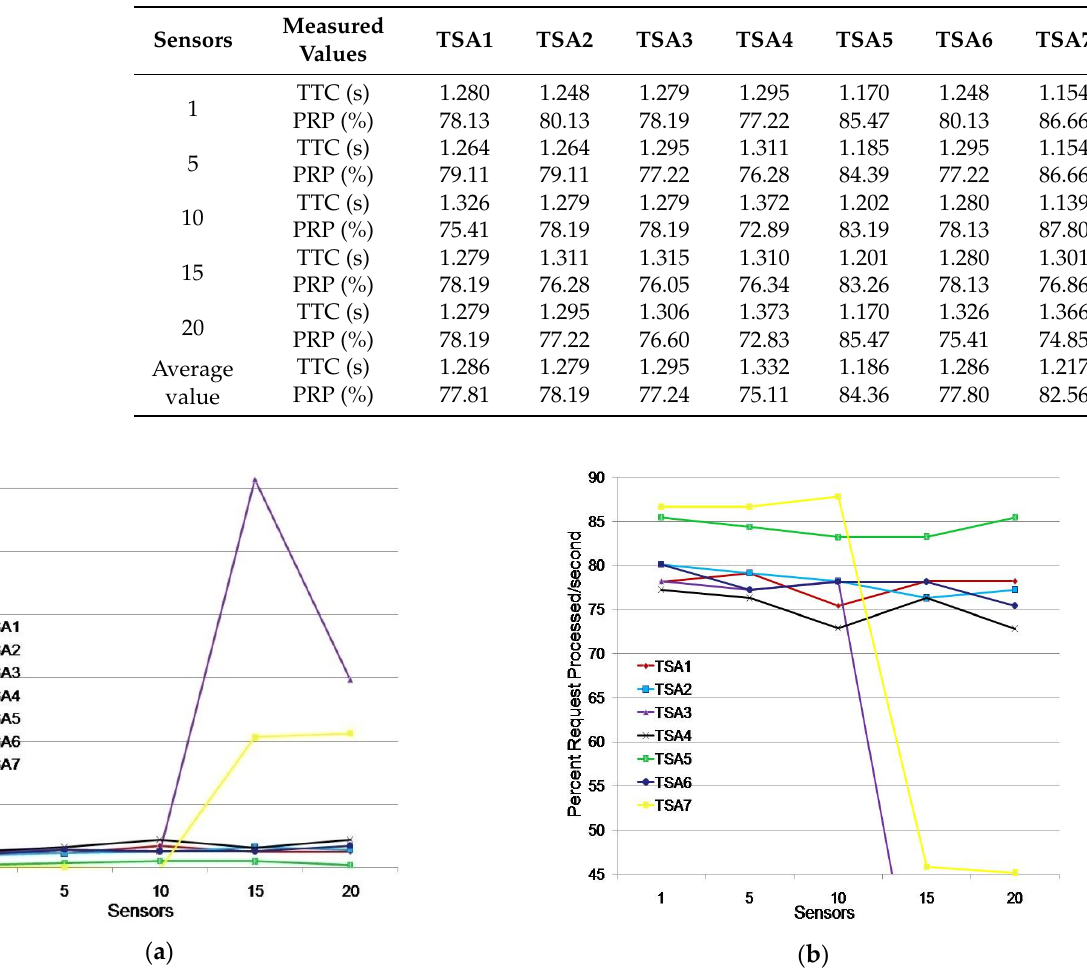
Figure 7. Issuing TSA timestamps for a single monitoring application environment: ( a ) total time consumed (s); ( b ) percentage of requests processed/s.